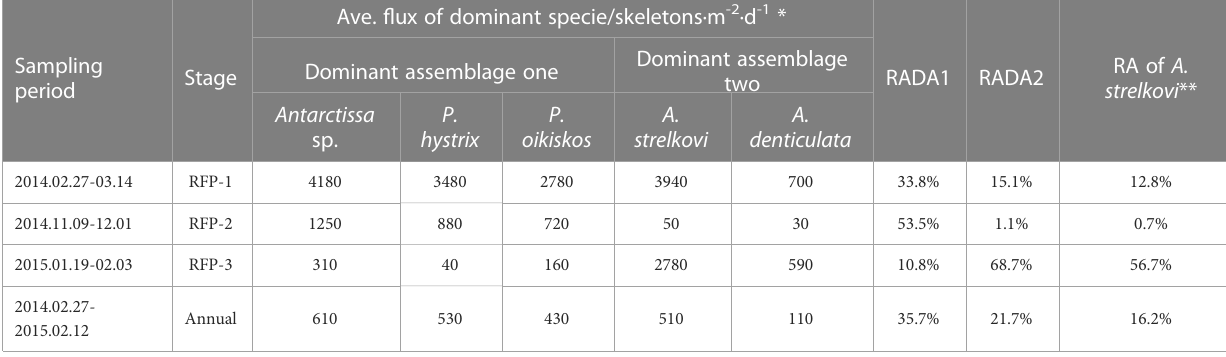
TABLE 4 Seasonal variations of dominant species fl uxes from the trap in Prydz Bay